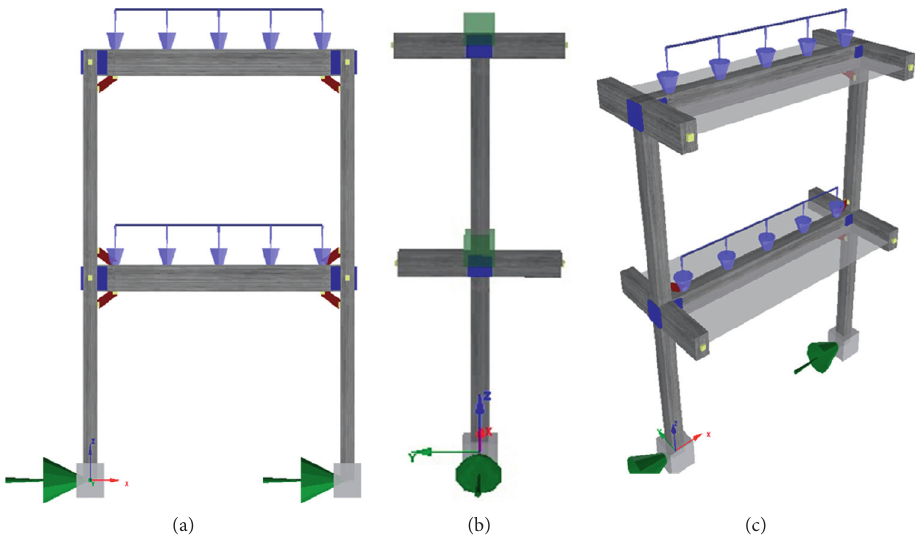
Figure 14: Numerical model of haunch retrofitted RC frame prepared in